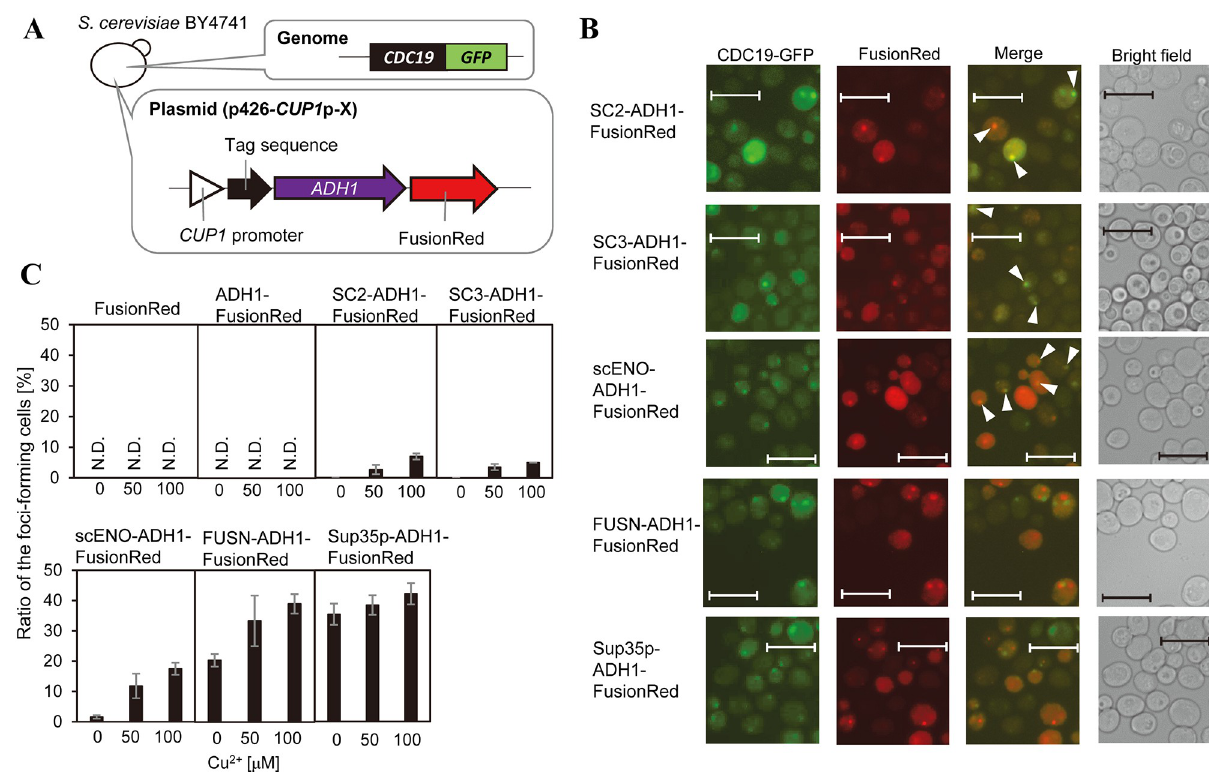
Fig 3. Production of Adh1p conjugated with foci-forming peptides and domains in S . cerevisiae under hypoxia. A: Overview of constructed yeast strains. ADH1 was fused with tag sequences (SC2, SC3, scENO, FUSN, or Sup35p) and FusionRed then Cu 2+ -dependently expressed using the CUP1 promoter. As a control, FusionRed or ADH1 fused with FusionRed were expressed using the CUP1 promoter. Within the genome of the host strain (CDC19-GFP), GFP is fused with CDC19 . Green fluorescence indicates the presence of condensates formed by Cdc19p (META body) under hypoxia. B: Localization of tagged Adh1p in CDC19-GFP cells under hypoxia. Green fluorescence indicates subcellular localization of Cdc19p. META bodies are seen as green foci. FusionRed demonstrates subcellular localization of tagged Adh1p. White arrow shows colocalized Adh1p with META bodies, and only foci that overlapped with META body markers were marked with arrows. C: Cu 2+ -dependent foci formation by tagged proteins. X axis shows CuSO 4 concentration ( μ M). The proportion of foci-forming cells was calculated as follows: foci-forming cells (%) = 100 × number of cells with red foci/ number of cells with red fluorescence. n = 3. Error bars show standard deviation.